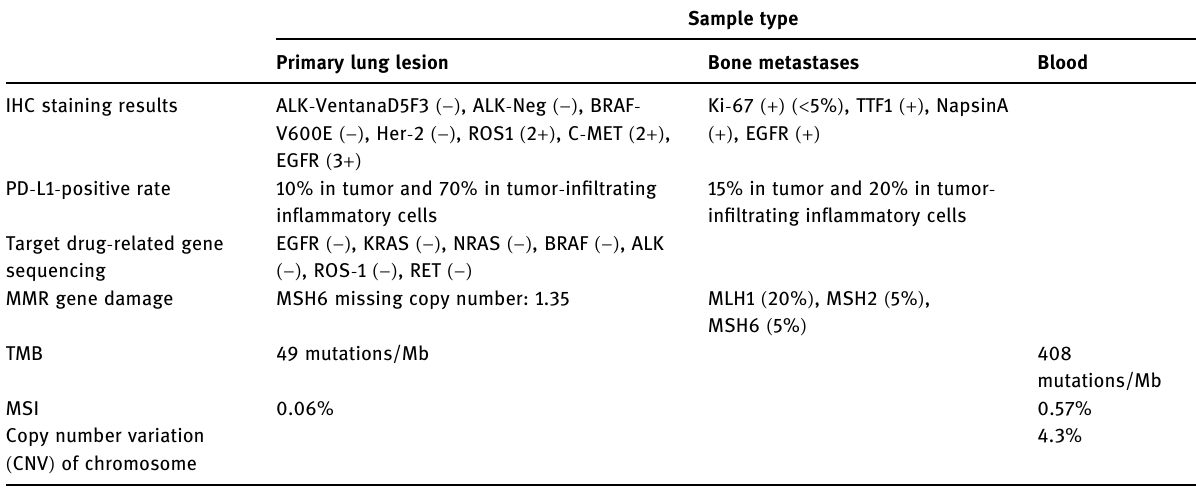
Table 1: Summary of the patient ’ s main tissue and blood specimen analysis results